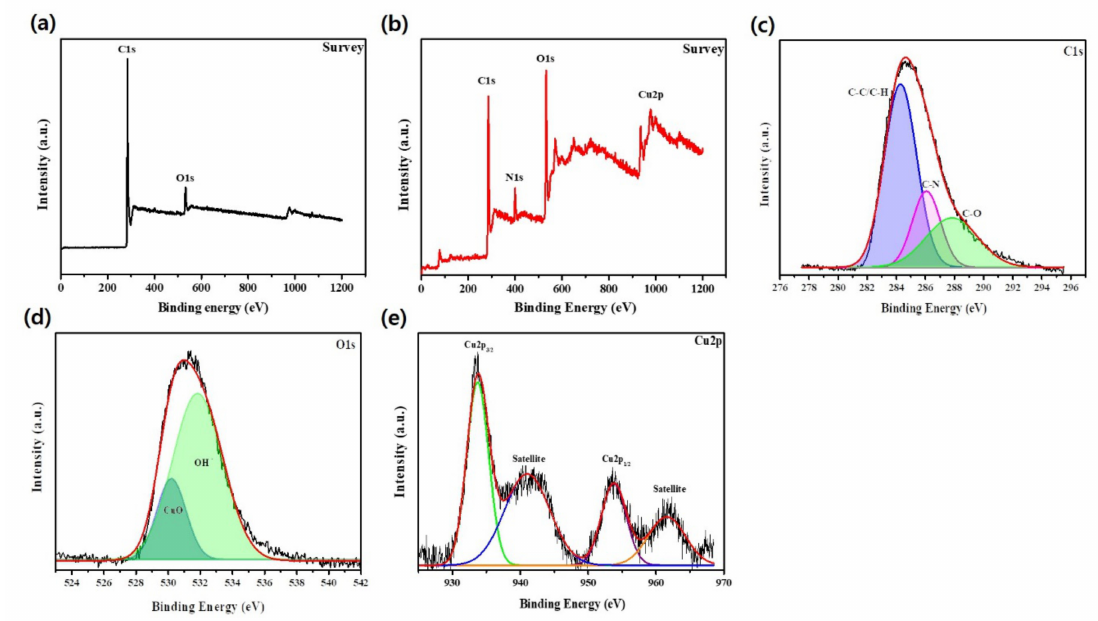
Figure 4. X-ray photoelectron spectroscopy (XPS) survey spectra of ( a ) pristine activated carbon fibers (ACF) and ( b ) ACF@ polydopamine-cupric oxide (PD-CuO)-12h, ( c–e ) deconvolution of peaks for C 1s , O 1s , and Cu 2p , respectively.